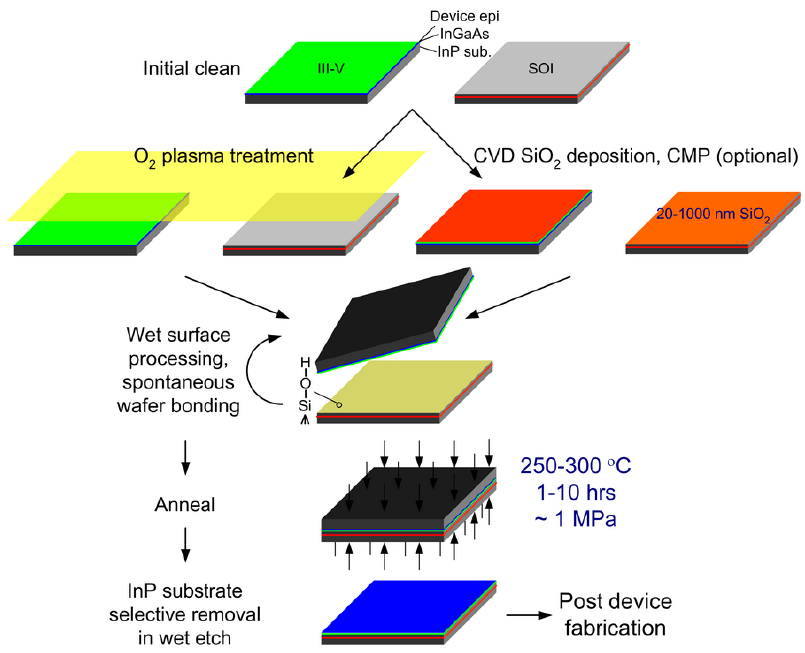
Figure 9. Schematic process flow for hydrophilic bonding of an Si-on-insulator (SOI) wafer and an InP wafer